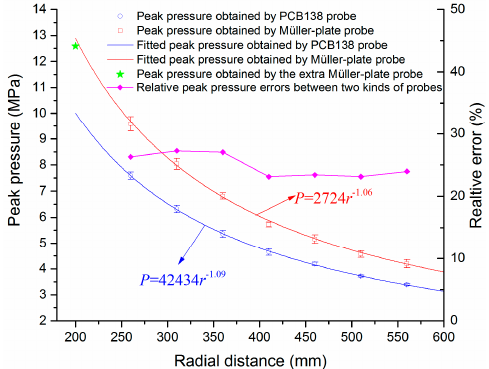
Figure 8. Dependence of the SW peak pressures and fitted values on the distance from the discharge channel.